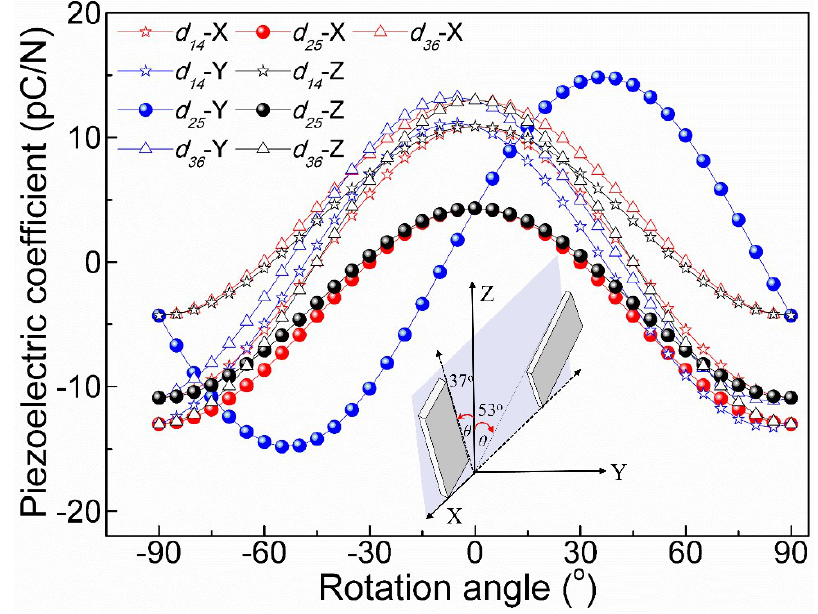
Figure 6. Orientation dependence of piezoelectric coefficient rotated around X -, Y - and Z-axes for α-BIBO crystals. The small inset shows the crystal cuts ( YZt /37° and YZt /−53°) with largest d 25 value.